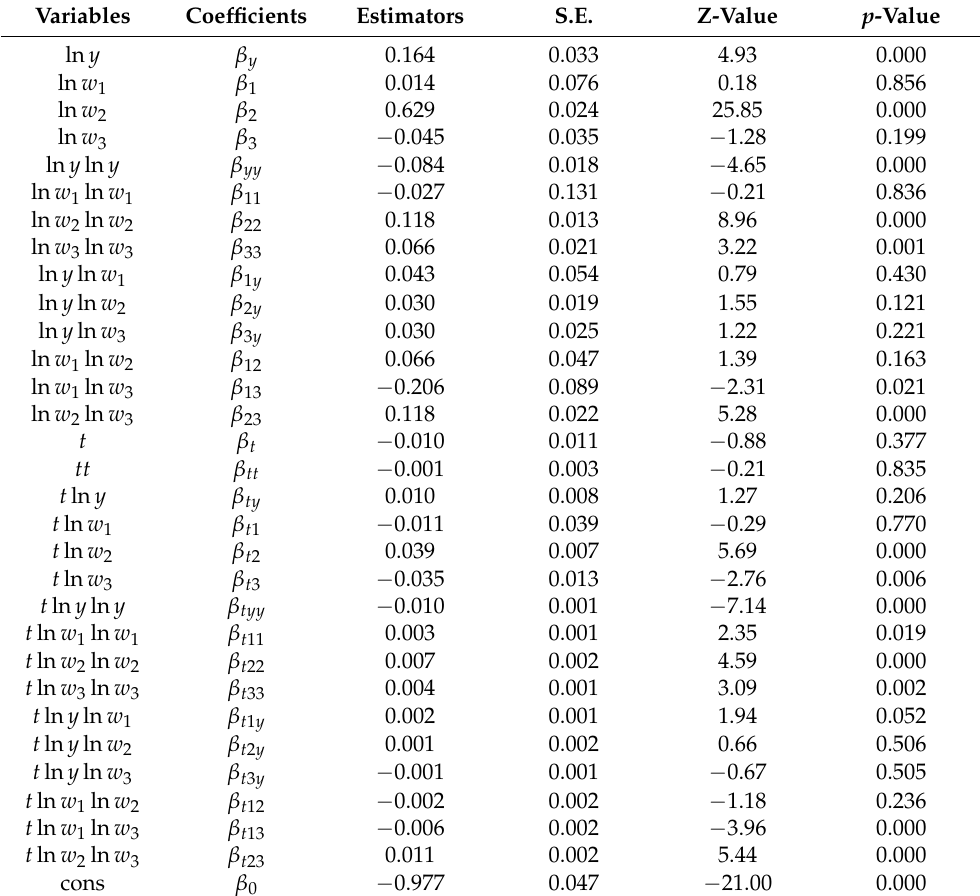
Table 6. Model estimation